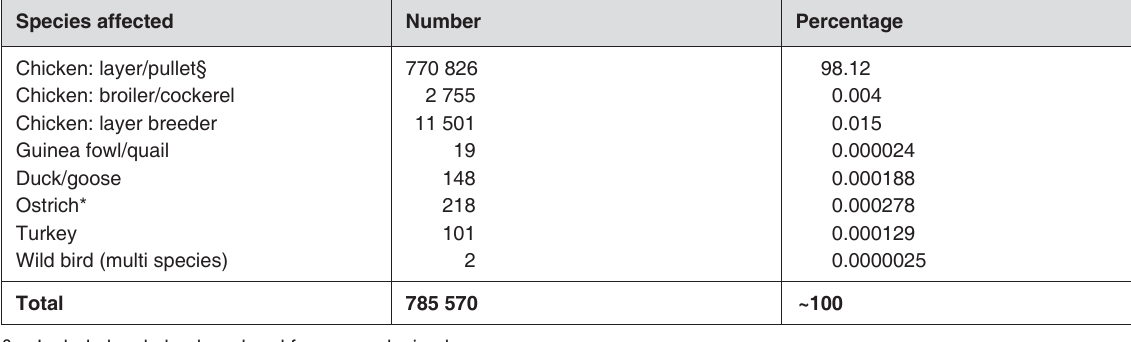
TABLE 1 Types and number of birds affected between 10 January and 31 August 2006